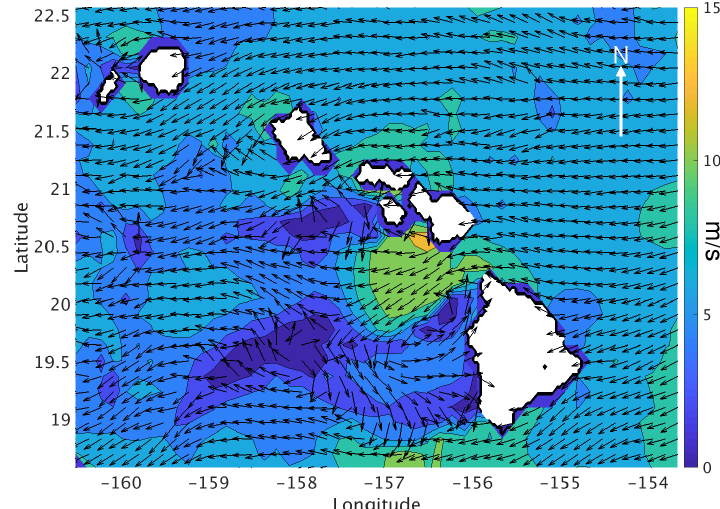
Figure 1. An example HRCM 3 km hourly wind vector field from 3:00 a.m. 26 June 2003. Wind speed is shown in color and wind direction quivers are downsampled and unit length. The land mask is shown in white. The reverse flow can be seen on the west side of the Big